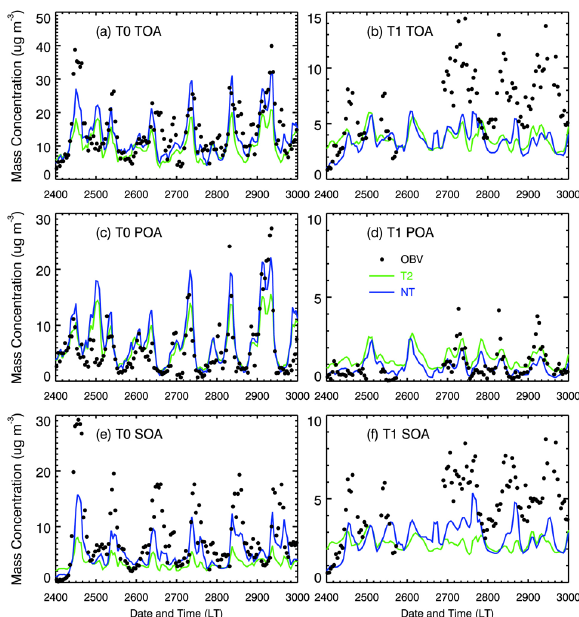
Fig. 4. Diurnal profiles of measured and simulated organic aerosol concentrations at T0 and T1 during the period from 24 to 29 March 2006. (a) TOA at T0, (b) TOA at T1, (c) POA at T0, (d) POA at T1, (e) SOA at T0, and (f) SOA at T1. Black dots: measurements; green line: the T2-SOA model; blue line: the NT-SOA